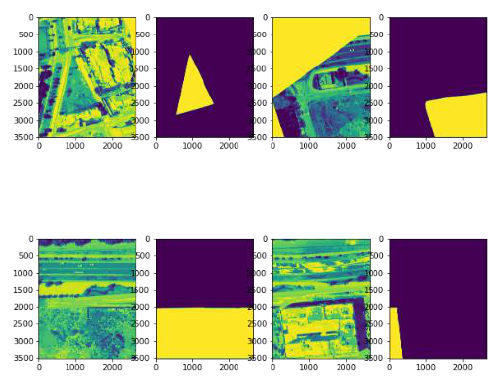
Figure 5 . Samples training pairs (Image &